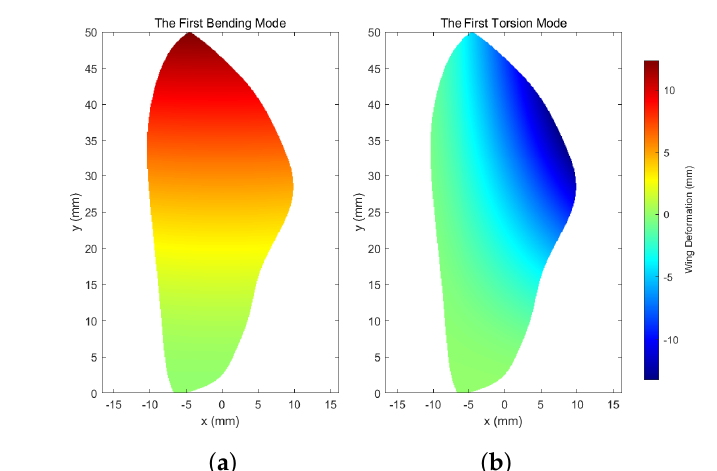
Figure 2. Prescribed wing mode shapes showing deformations in mm: ( a ) first bending mode and ( b ) first torsion